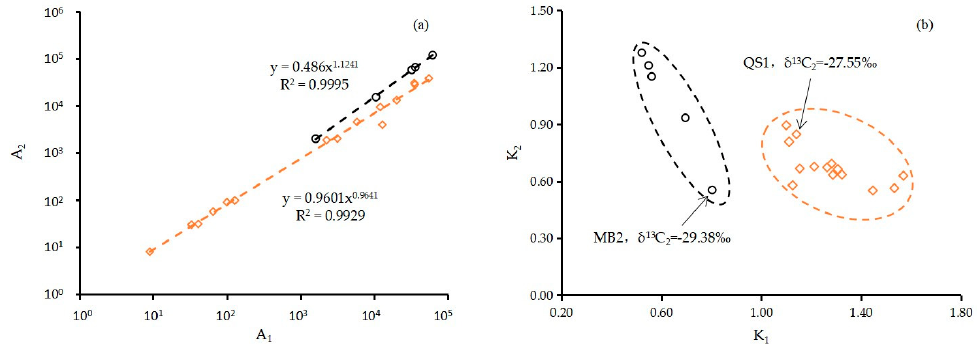
Figure 6. Cross-plots of A 1 vs. A 2 ( a ) and K 1 vs. K 2 ( b ) for the light hydrocarbons associated with the natural gas in the Eastern belt around the Penyijingxi sag, Junggar Basin (Plate from ref. [50]).